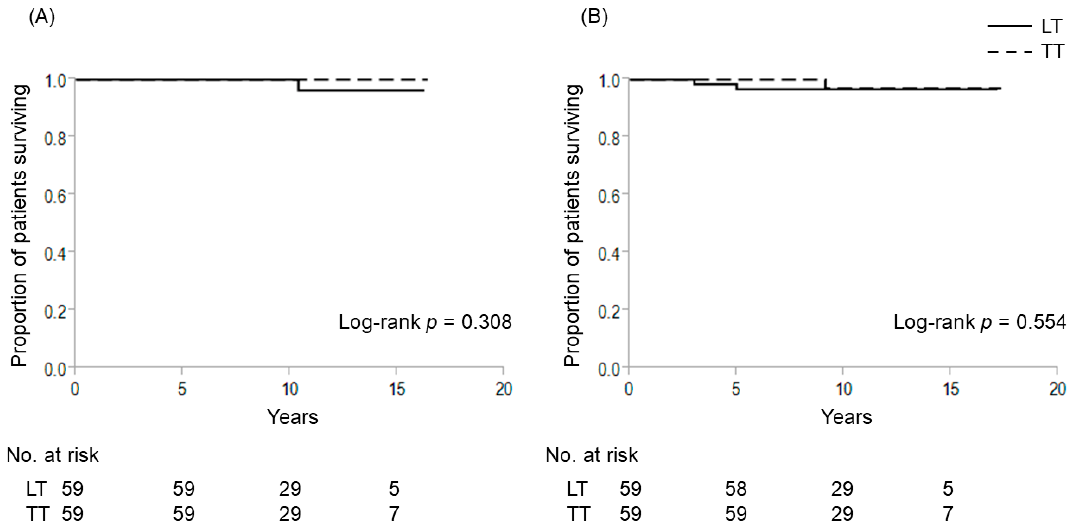
Figure 4. Cause-specific and disease-free survival curves for patients without TERT promoter mutations who underwent lobectomy and total thyroidectomy for patients with intrathyroidal PTC with a maximal diameter of 1–4 cm. ( A ) Cause-specific survival; ( B ) disease-free survival. LT, lobectomy; TT, total thyroidectomy.